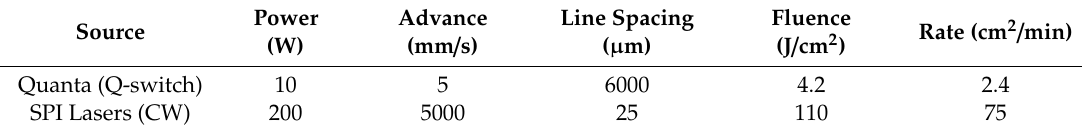
Table 5. Laser stripping trials values in order to obtain the maximum stripping rate.